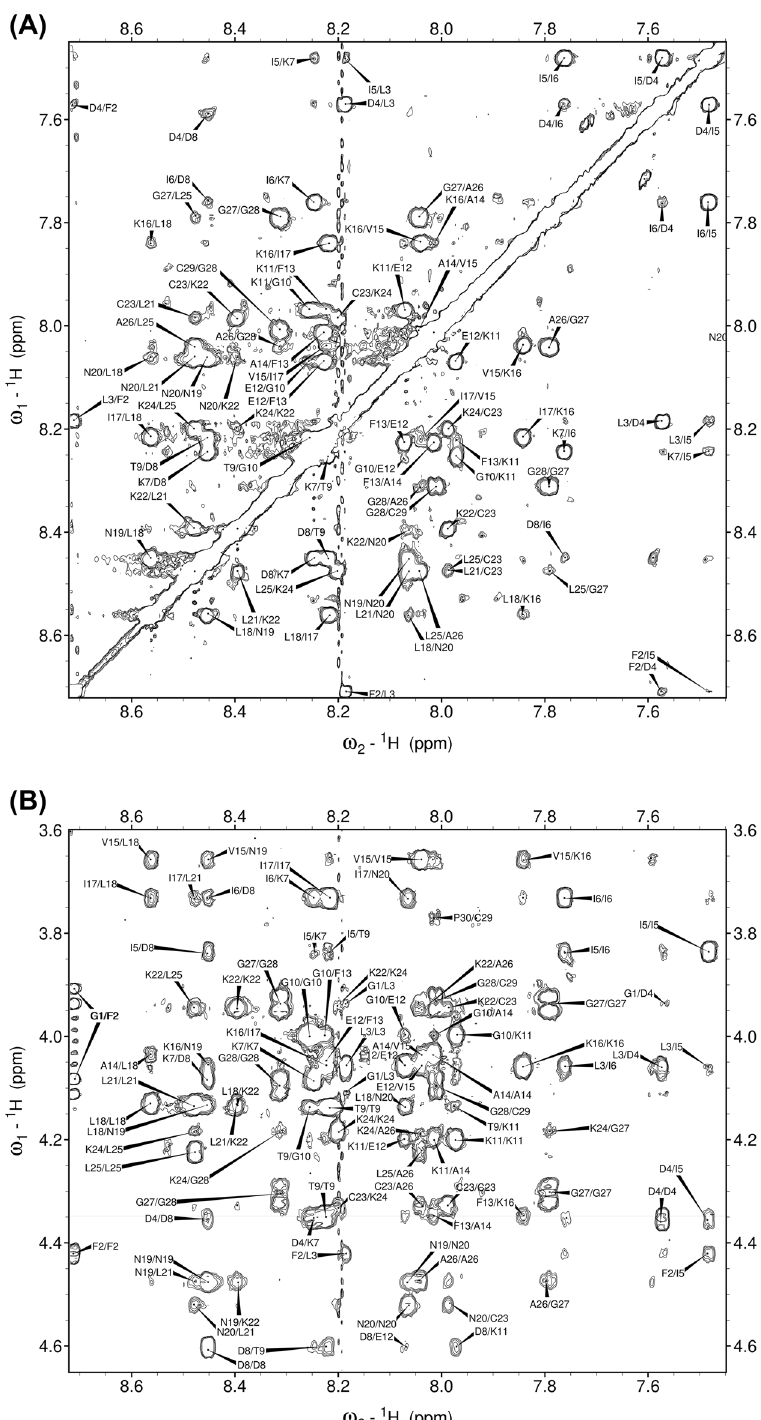
Figure 1. ( A ) Amide and ( B ) fingerprint regions of the 200 ms NOESY spectrum of palustrin-Ca in 50% TFE- d 3 -H 2 O mixed solvent